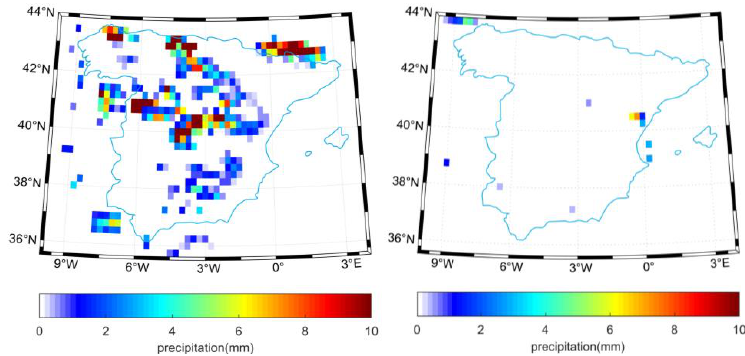
Figure 8. TRMM precipitation over Spain on 15 April (left) and 27 July (right) 2014.